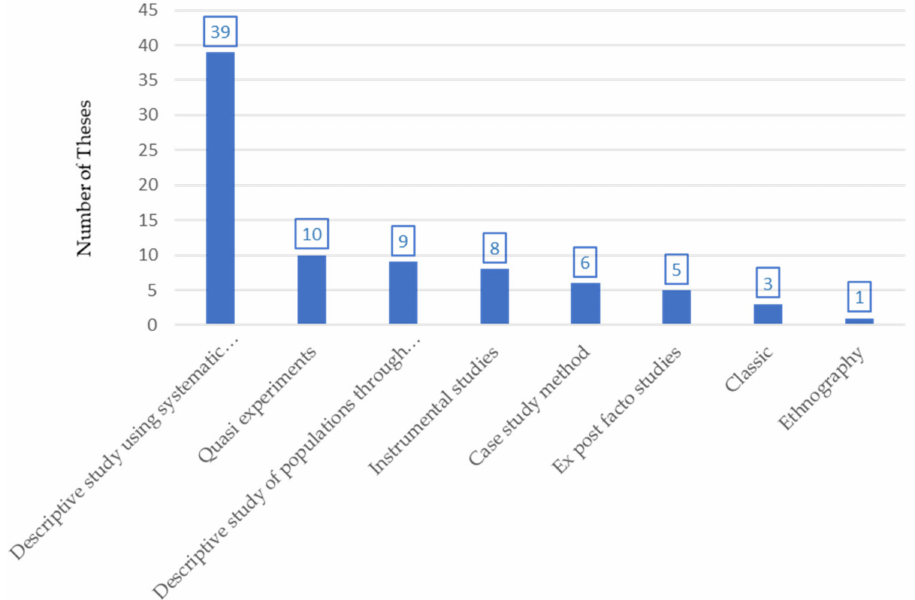
Figure 4. Distribution of the research methods used in the doctoral theses on